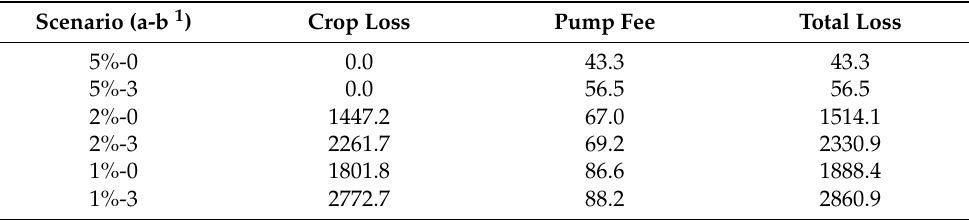
Table 3. Waterlogging loss of study area under different initial storage depths in the current condition (unit: 10 3 yuan).